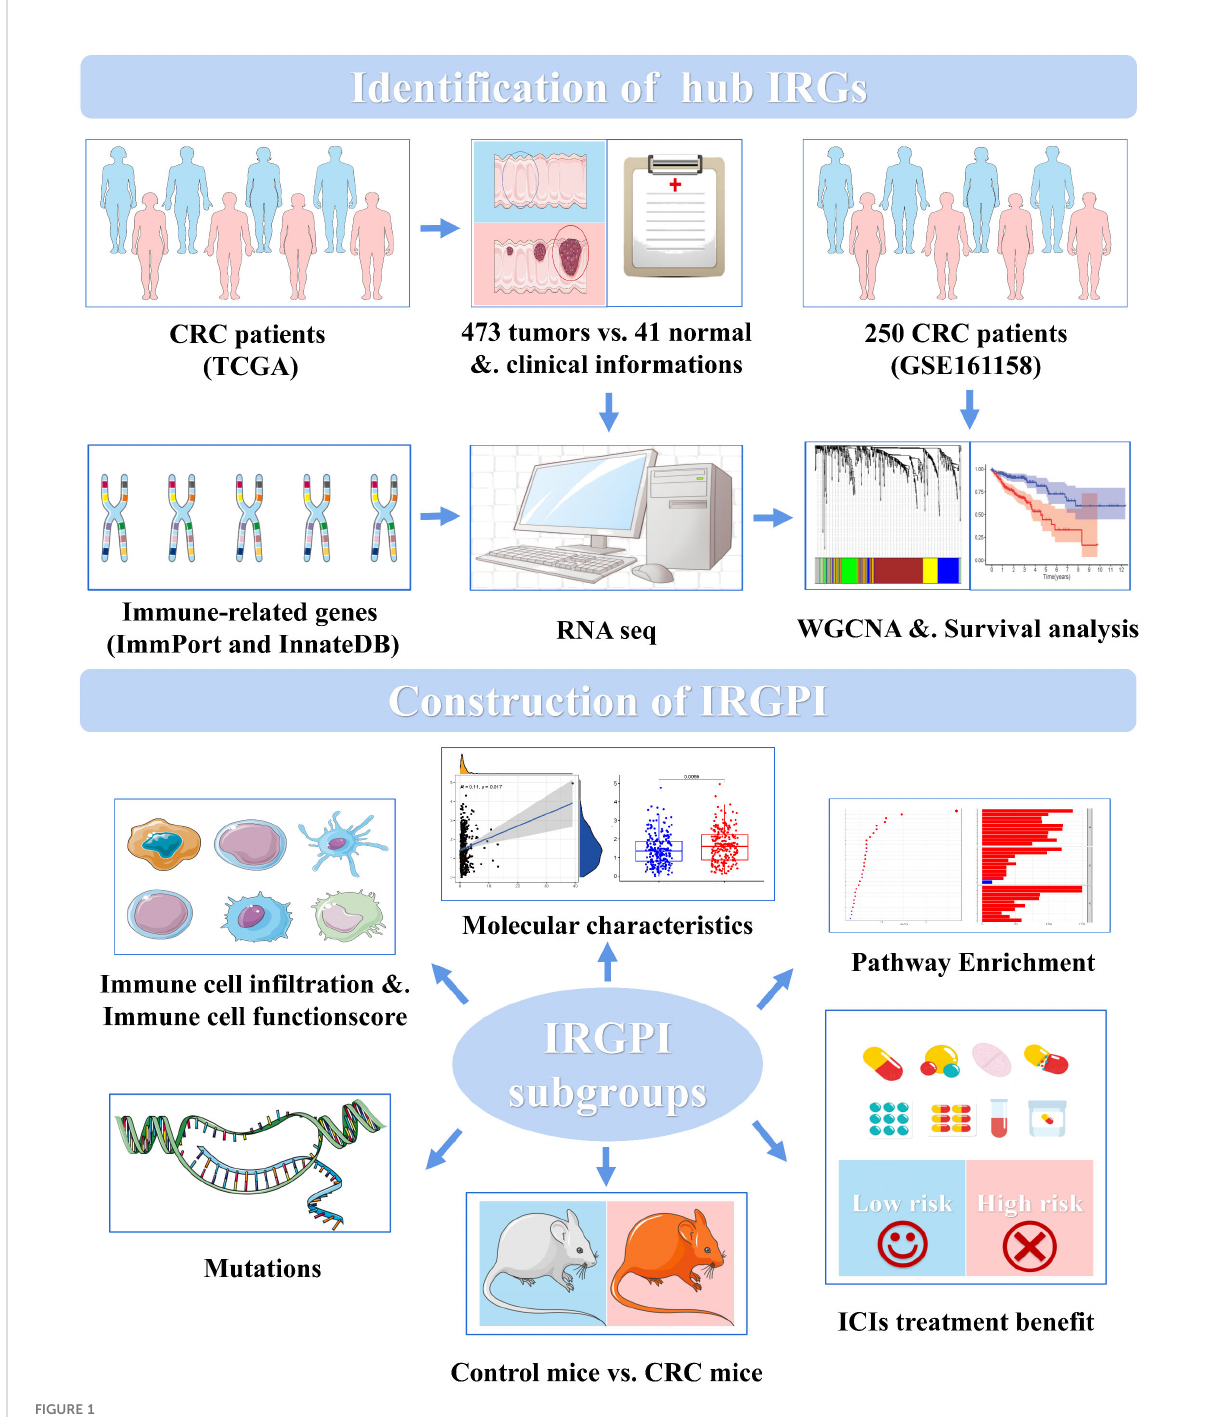
FIGURE 1 CRC IRGPI experimental technical